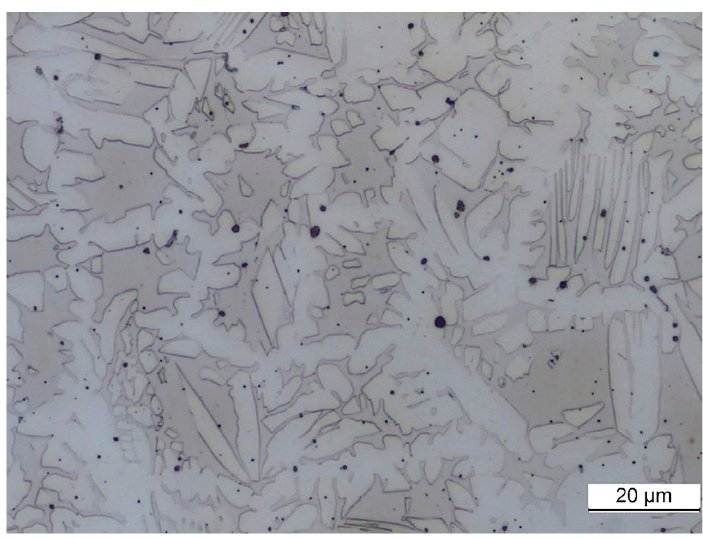
Figure 7. Microstructure of primary (non-reheated) region, next last layer of Wall 1.